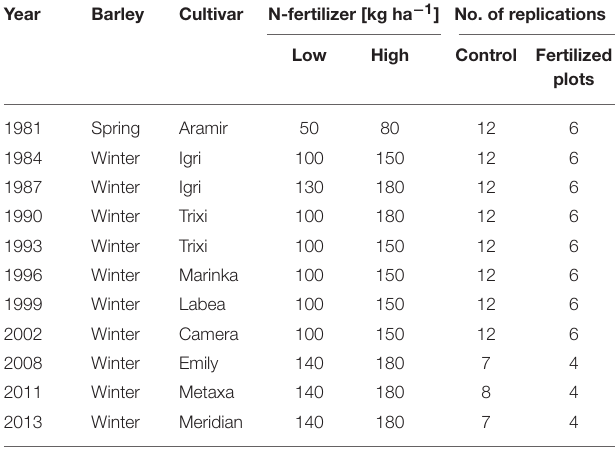
TABLE 3 | Cultivars, amount of fertilizer, and number of